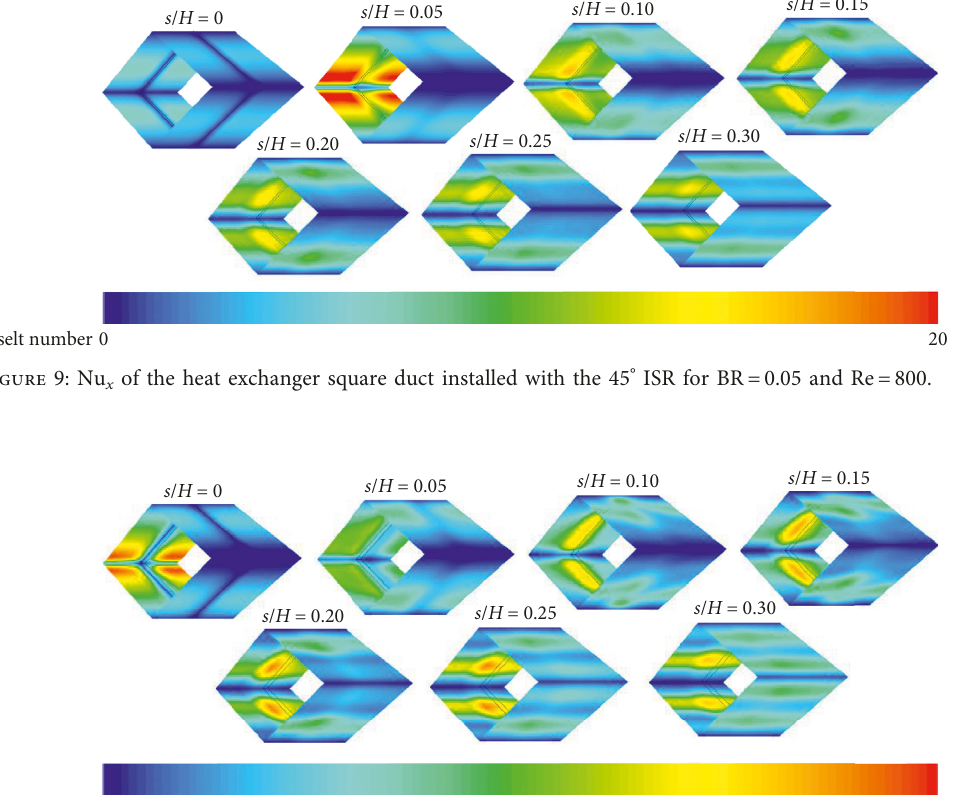
° ISR for BR � 0.10 and Re � 800.